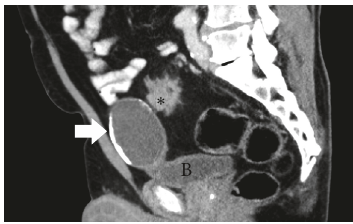
Figure 1: Sagittal image from contrast enhanced CT demonstrating a 6.9 cm rim calcified cyst (see Arrow) arising from the dome of the urinary bladder (labelled “B”) corresponding to a urachal cystic tumor of low malignant potential. Immediately posterior to this is the 6.5 cm sigmoid colon adenocarcinoma (labelled ∗ ), represented as circumferentially thickened bowel with luminal narrowing and irregular serosal surface seen in